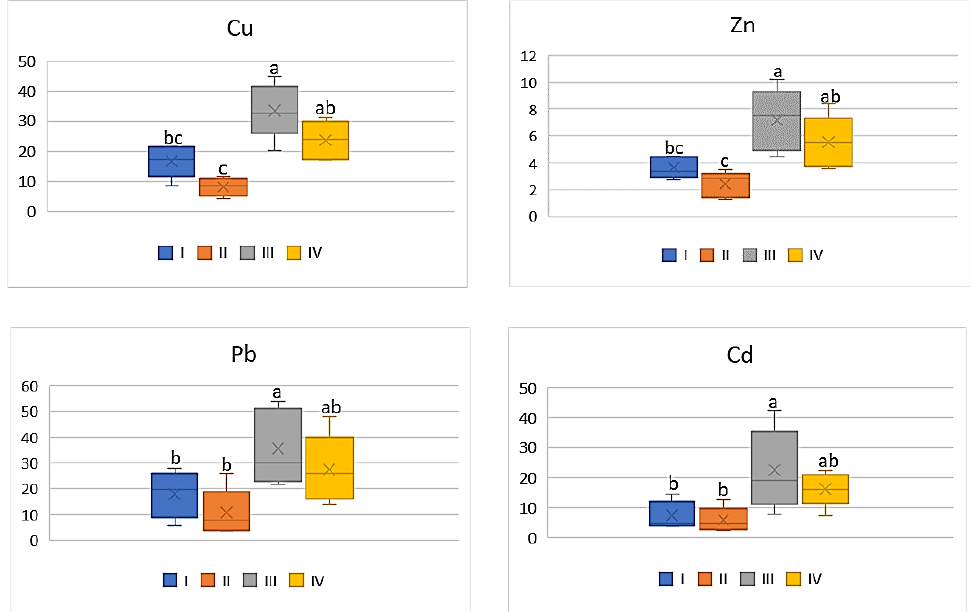
Figure 11. HRI values for cabbage depending on the metal and study zones. The same letters mean no significant differences between the values.